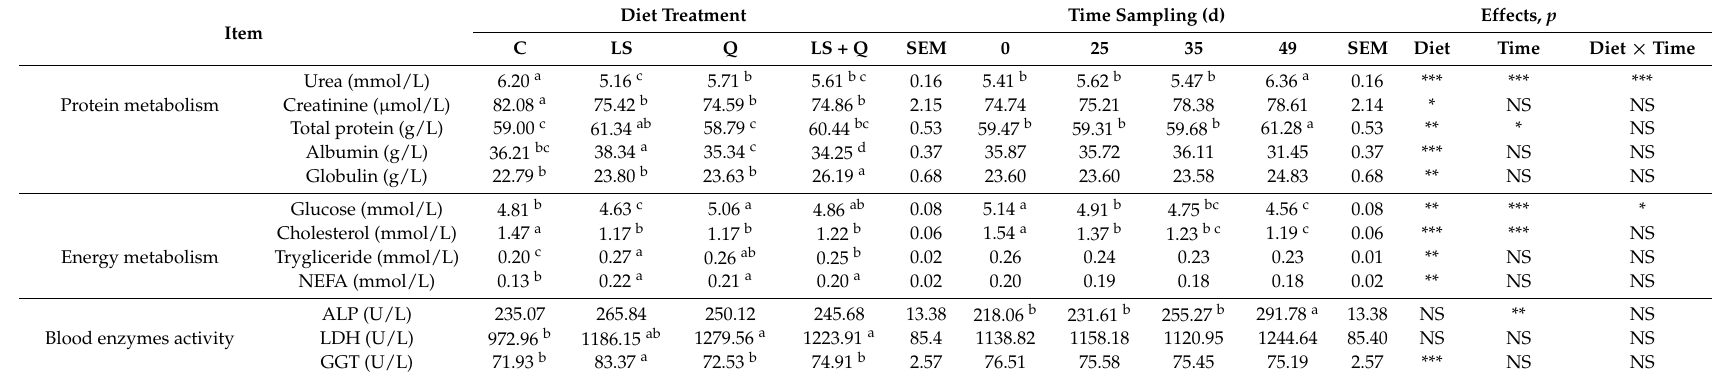
Table 2. Effect of diet treatment and time sampling on metabolic profile parameters of merinos-derived lambs (C = control; LS = linseed; Q = quinoa seed; LS + Q = linseed + quinoa seed), (mean ±